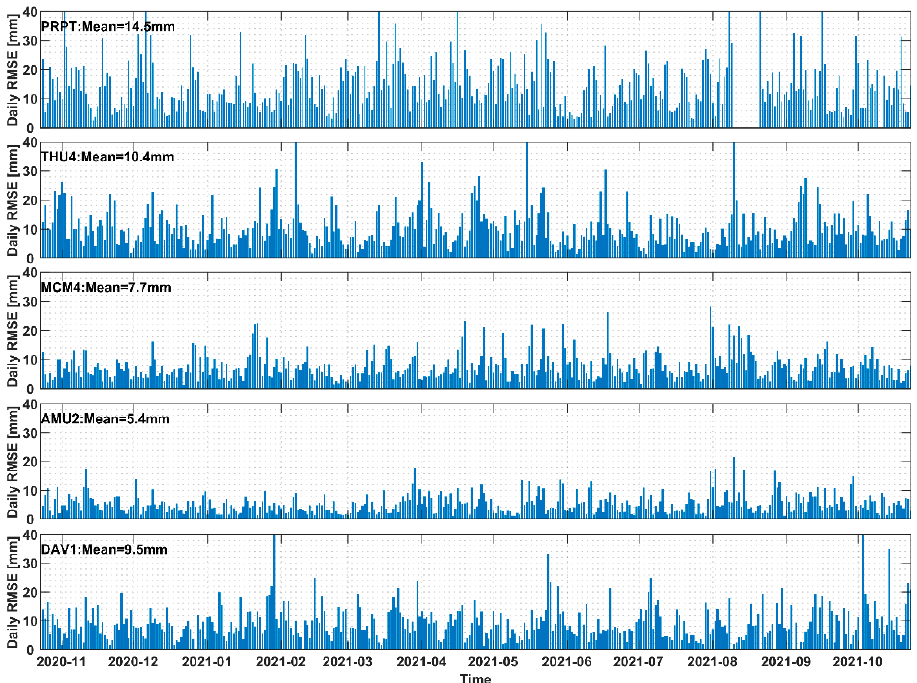
Figure 12. Daily RMSE of LSTM_ZTD from 24 October 2020 to 23 October 2021 at PRPT, THU4, MCM4, AMU2 and DAV1 station.